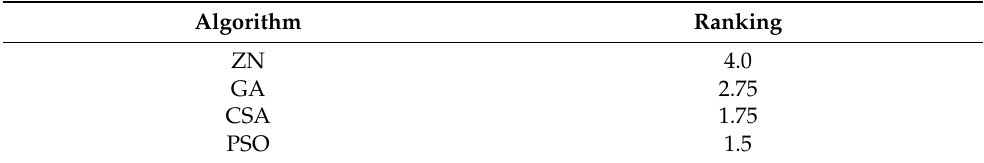
Table 4. Average order of the optimization methods based on Friedman’s test using the overshoot metric